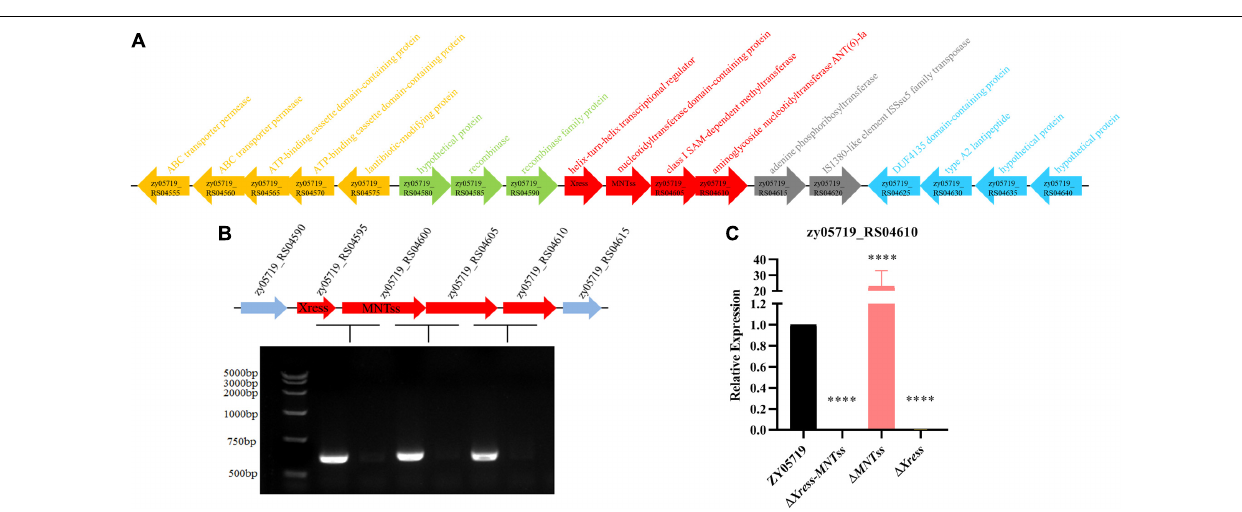
FIGURE 4 | Xress-MNTss regulates the zy05719_RS05610 gene. (A) Putative genomic island genes annotation. (B) ZY05719_RS04595 , zy05719_RS04600 , zy05719_RS04605 , and zy05719_RS04610 formed an operon, as determined by RT-PCR. An RNA sample without reverse transcription served as a negative control. (C) Expression of zy05719_RS04610 in ZY05719, (cid:49) Xress-MNTss , (cid:49) MNTss , and (cid:49) Xress strains as measured by qRT-PCR. Values are shown as the means plus standard deviations (error bars) from at least three independent experiments. Unpaired two-tailed Student’s t -test: P <